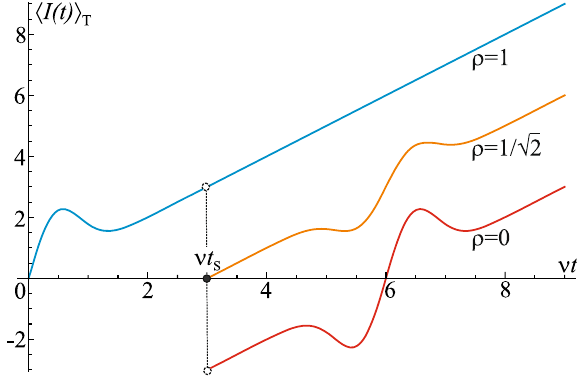
Fig. 5 Average current (over period T ). Average current I ð t Þh i T is plotted dependent on time t for mechanical frequency of 1GHz, ratio E J / ℏ ω = 1.4 and different values of ρ (continuous lines are interpolated through the I ð N Þh i T points, I ð N s Þh i T ! I ð t s Þh i T ¼ 0